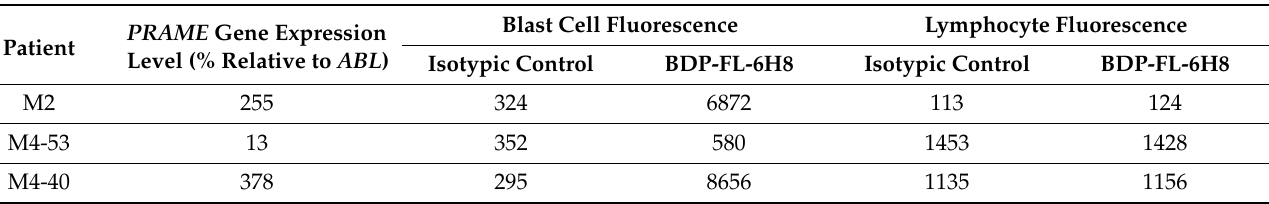
Table 1. Staining the bone marrow cells populations from AML patients; data are given in median fluorescence intensity (MFI)